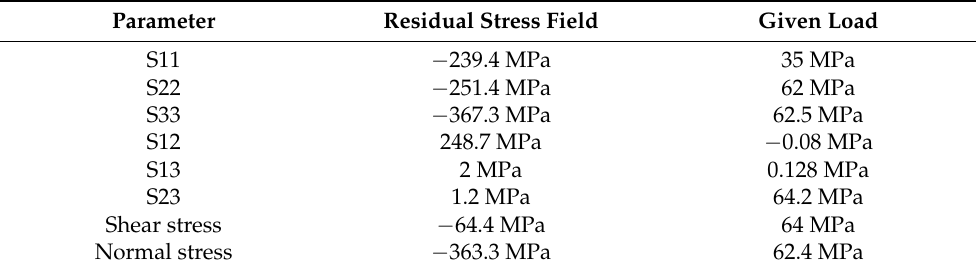
Table 4. Components of the stress sensor of crankshaft N1 from different sources. Parameter Residual Stress Field Given